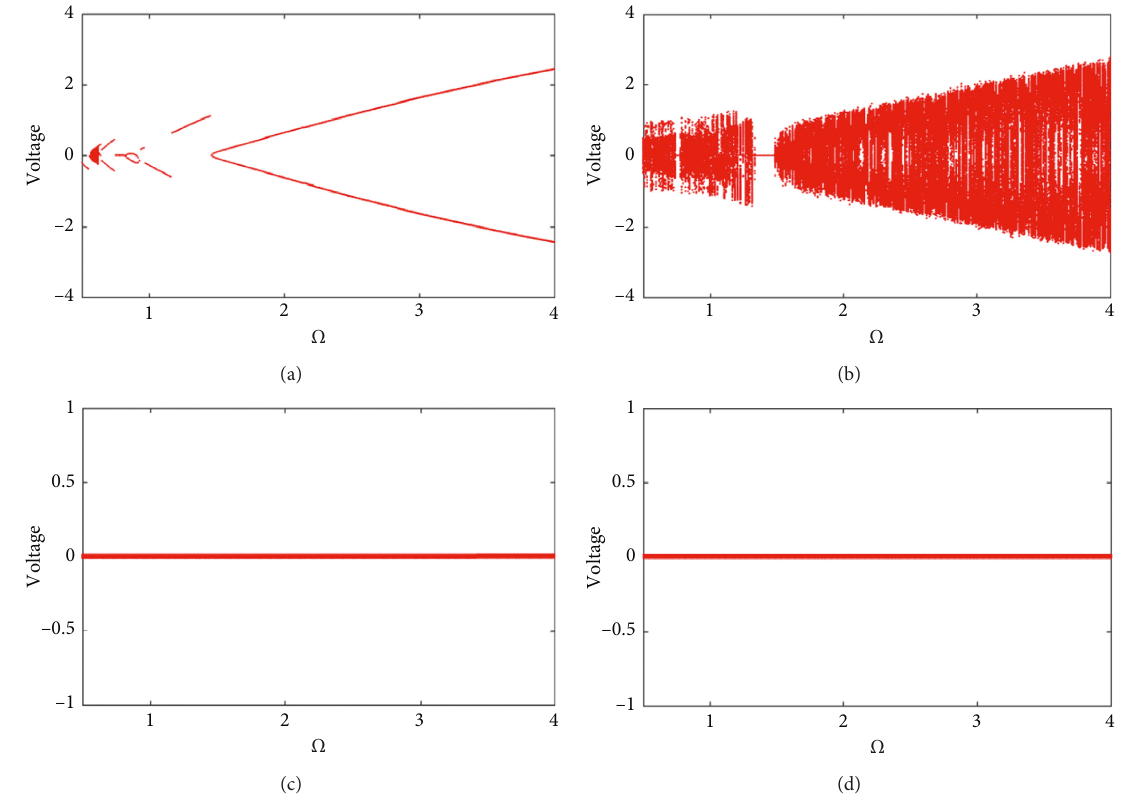
Figure 12: Bifurcation diagram of the output voltage with the variation in Ω : (a) c � 0 . 0 for the tristable system; (b) c � 0 . 1 for the tristable system; (c) c � 0 . 0 for the monostable system; (d) c � 0 . 1 for the monostable